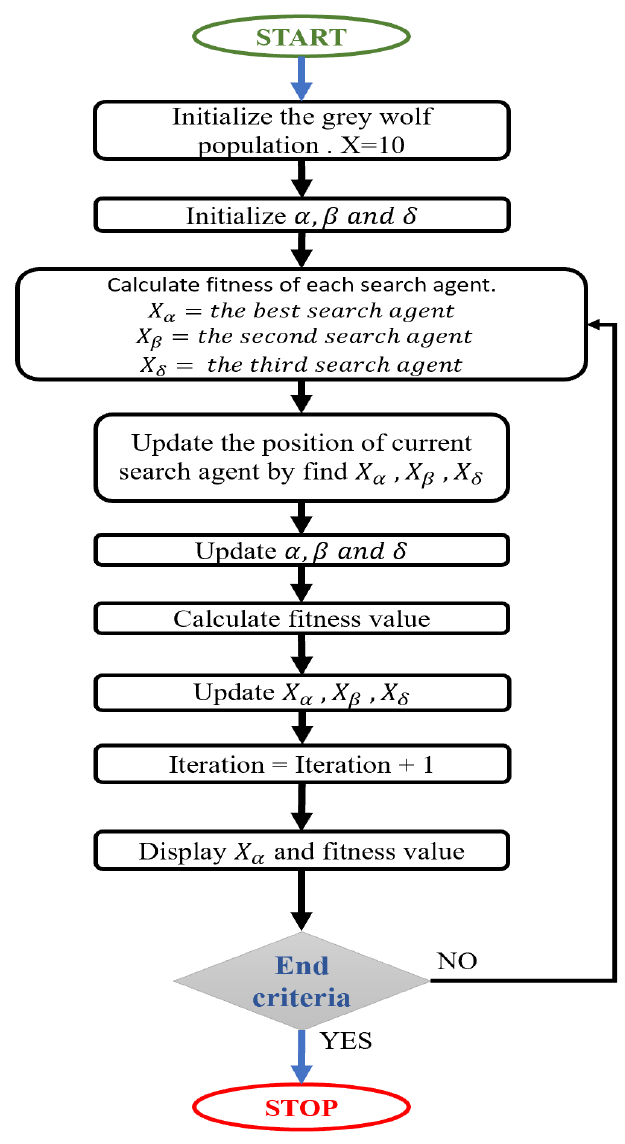
Figure 5. Implementation steps of binary gray wolf optimization.